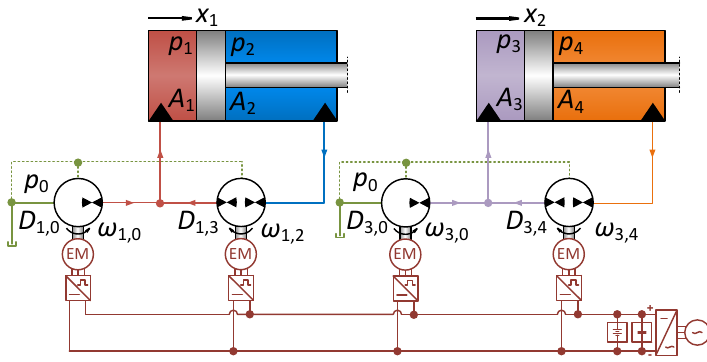
Figure 10. Schematic for VDN-PP with interconnection scheme 0 ↔ 1, 0 ↔